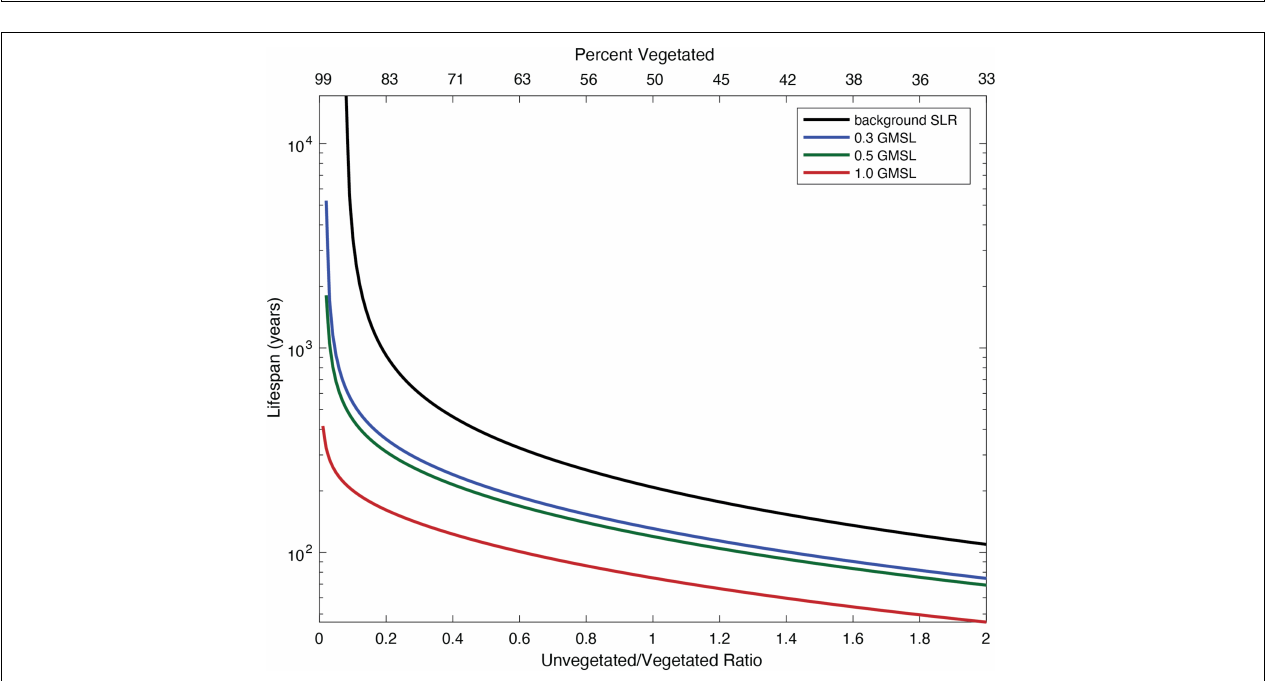
FIGURE 3 | Relationship among the width of a vegetated leading edge, UVVR, and percent reduction in wave energy over the first 100 m of marsh for (A) low-, (B) medium-, and (C) high-intensity wave scenarios.